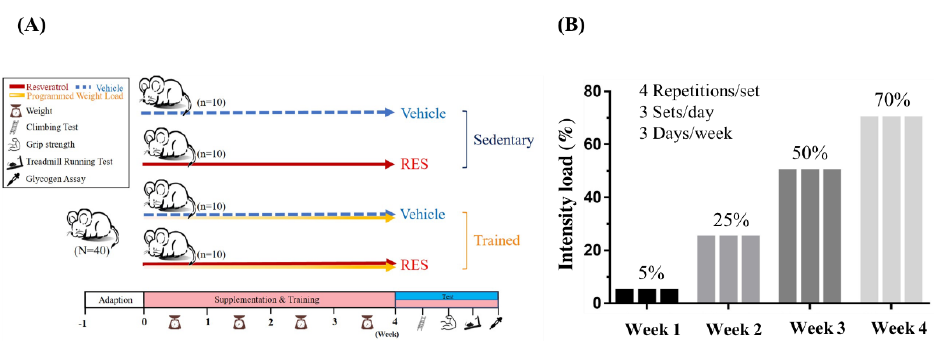
Figure 2. The experimental procedure to evaluate the effects of progressive resistance exercise and resveratrol on aerobic capacity, anaerobic capacity, physiological adaption, and safety ( A ). The incremental loading intensity applied to current training protocol ( B ).